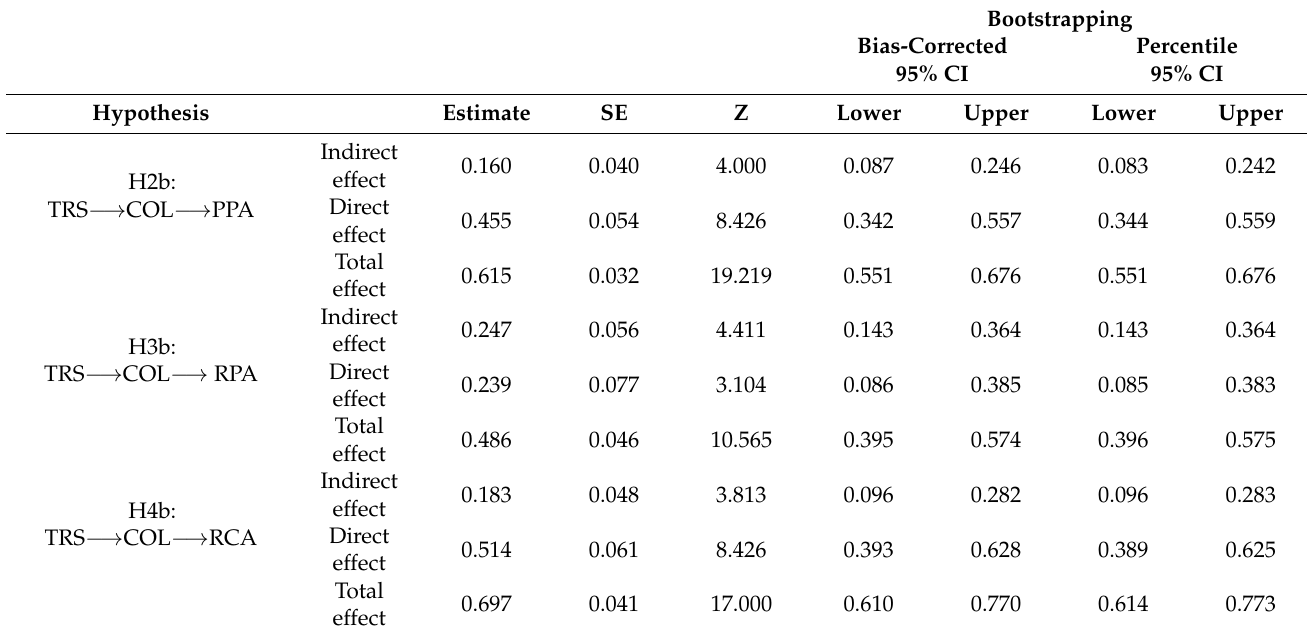
Table 8. Mediation effect results.